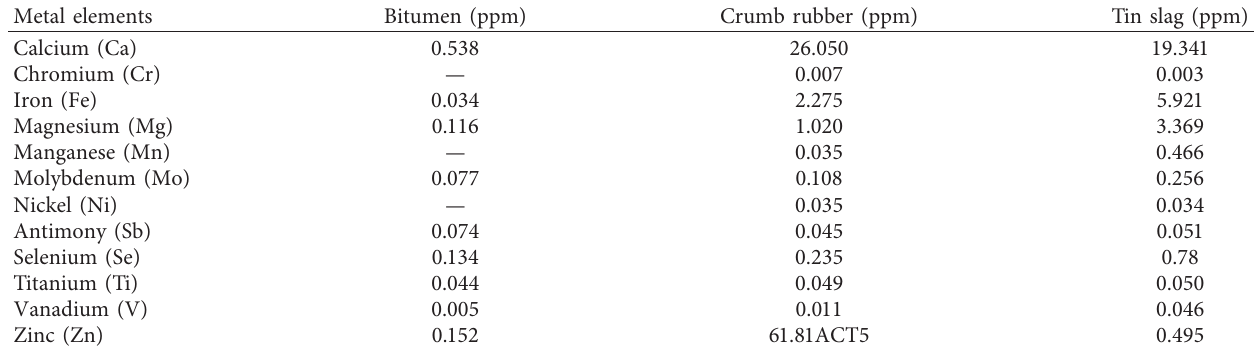
Table 7: Metal elements’ concentrations on bitumen, crumb rubber powder, and tin slag leachate